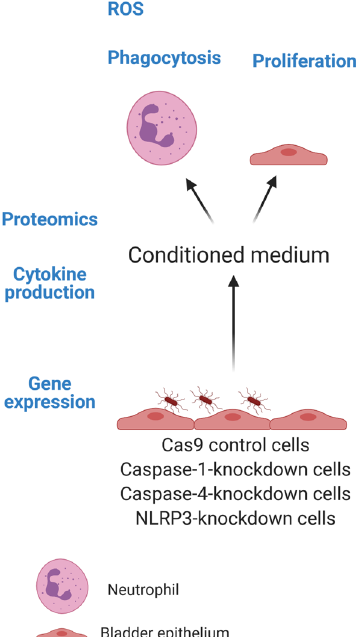
Figure 1. A schematic overview summarizing the experimental design. Caspase-1, caspase-4 and NLRP3- knockdown bladder epithelial cells and Cas9 controls were infected with the UPEC strain CFT073. Measurement of gene expression and cytokine release (IL-1β, IL-18, IL-8) from infected cells was evaluated by ELISA. Conditioned medium collected from respective knockdown cell line was analyzed by proteomics using a panel of inflammatory proteins. The conditioned medium was also used to evaluate ROS production and phagocytosis in neutrophils and cell proliferation from bladder epithelial cells (created with